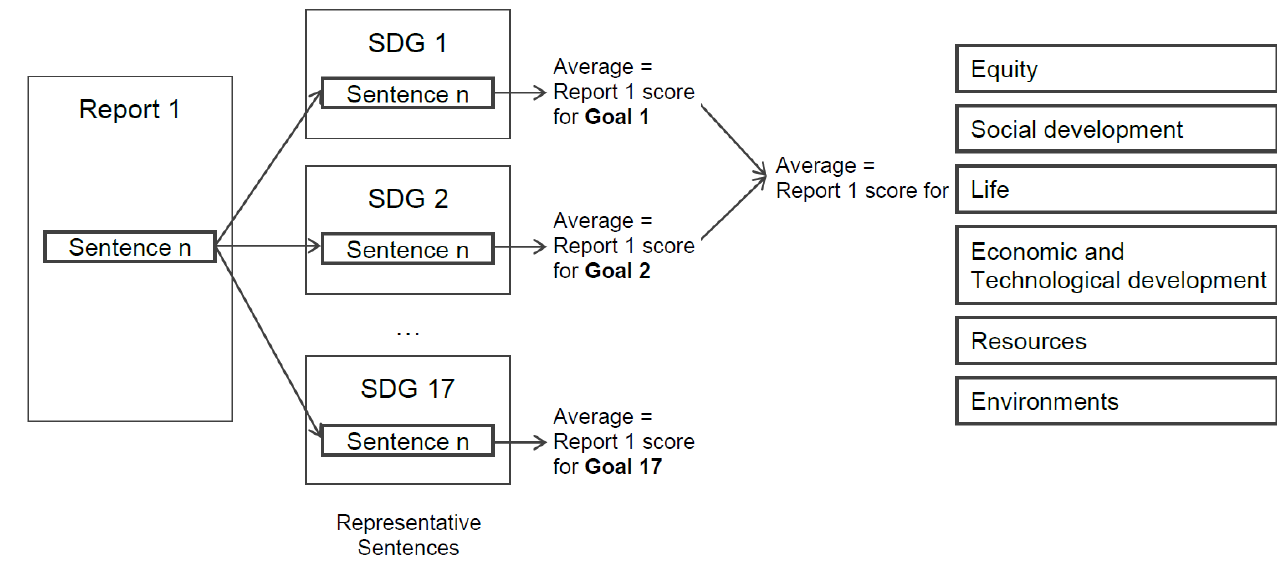
Figure 2. Sentence similarity score calculation process.